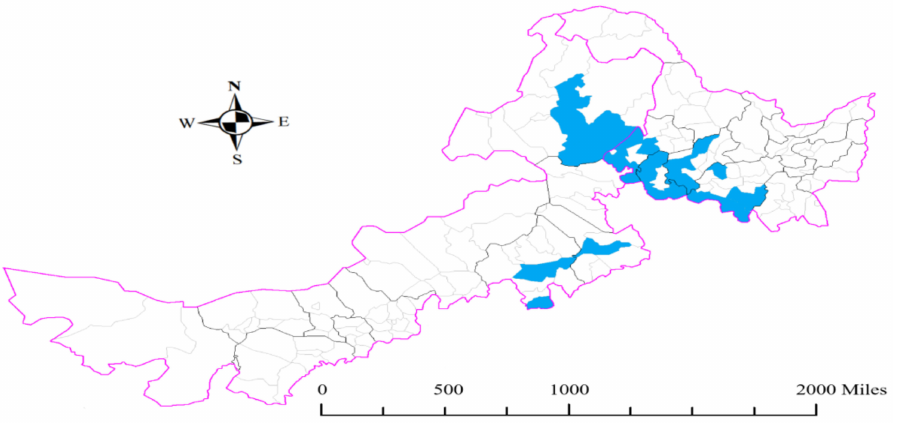
Figure 2. Location and scope of the study